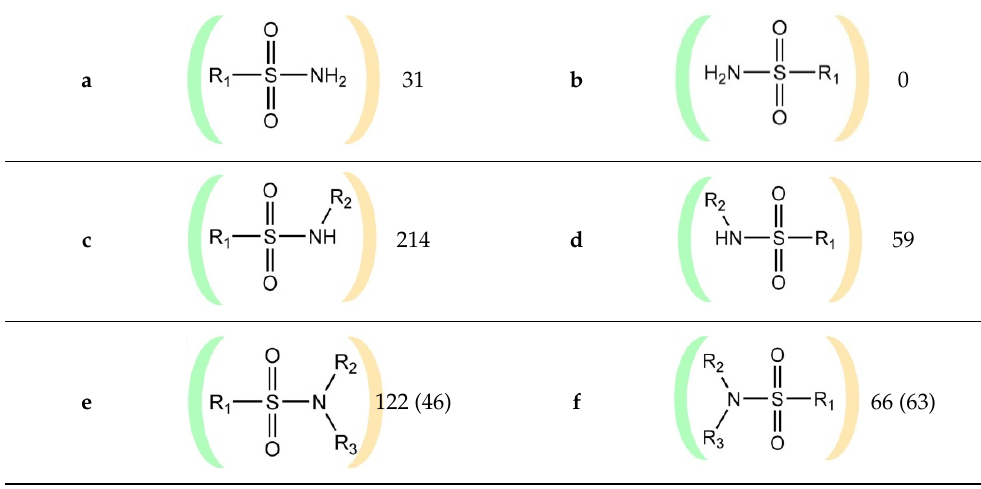
Table 2. Possible orientations of sulfonamides in the active site of neuraminidase: ( a ) and ( b ) unsub- stituted, ( c ) and ( d ) monosubstituted, ( e ) and ( f ) disubstituted compounds. Green color represents the sialic acid cavity, orange represents the 430-cavity. For each variant, the number of sulfonamides selected by virtual screening of the ZINC12 library against N1 model is indicated (number in parentheses refers to disubstituted sulfonamides in which the nitrogen atom is incorporated into the heterocycle).